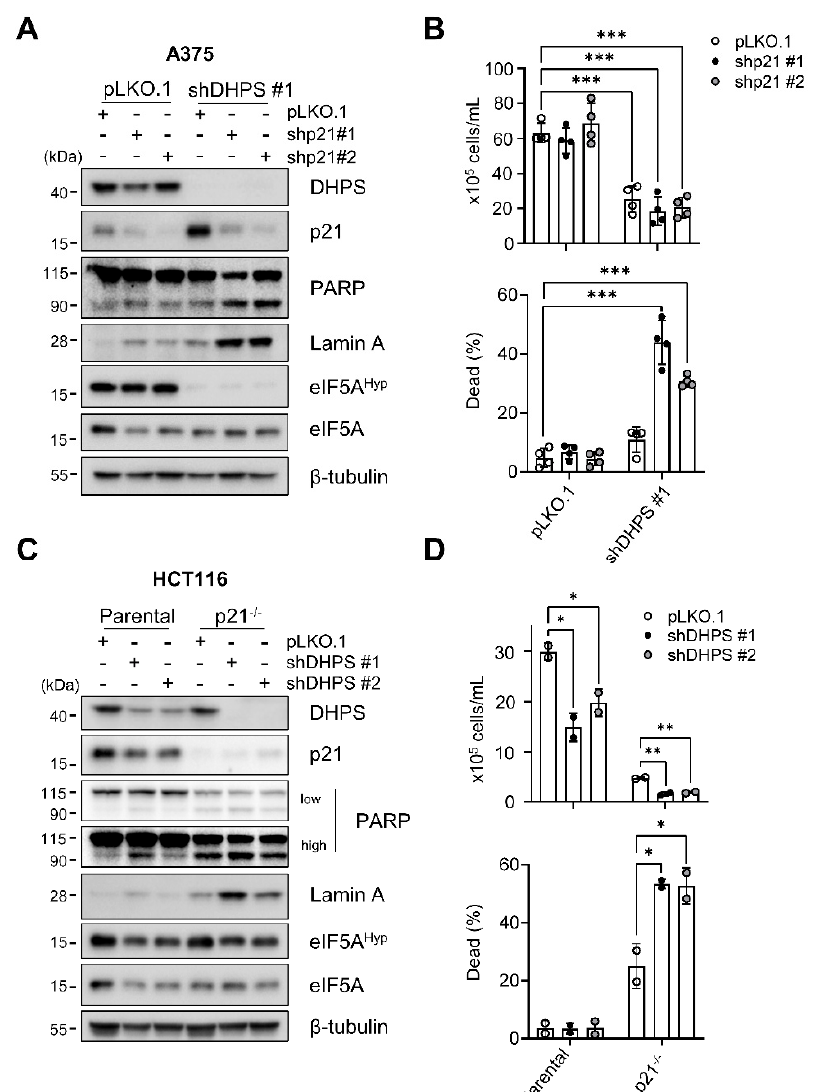
Figure 3. p21 CIP1 depletion switches DHPS knockdown ‐ induced growth arrest to cell death. ( A ) Western blots of total lysates of cells co ‐ infected for 5 days with pLKO.1 ‐ shDHPS virus and pLKO.1 viruses expressing shRNA targeting different regions of CDKN1A mRNA (shp21 #1 and shp21 #2). β‐ tubulin is the control for equal protein loading. Empty virus was used as a control. ( B ) Trypan blue exclusion assays to determine viability of A375 cells infected as described in ( A ). ( C ) Western blots of total lysates of parental and p21 − / − HCT116 cells infected with pLKO.1 ‐ shDHPS virus for 5 days. ( D ) Trypan blue exclusion assays to determine viability of HCT116 cells infected as described in ( C ). Data are mean ± SD of biological triplicate and duplicate. * p < 0.05, ** p < 0.005, and *** p < 0.001 by two ‐ tailed Student t ‐ test.